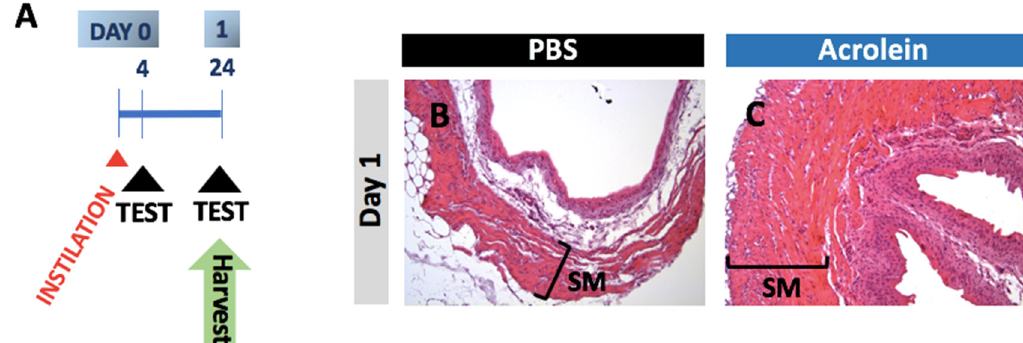
Figure 1. Conventional model of 85 µL acrolein-induced thickened smooth muscle in urinary bladder. ( A ) Experimental design to study the effects of a one-time transurethral instillation of 85 µL acrolein in the urinary bladder of adult C57BL6/J mice. ( B , C ) Representative images of hematoxylin and eosin (H&E)-stained images of the urinary bladder of mice in the PBS and acrolein groups.